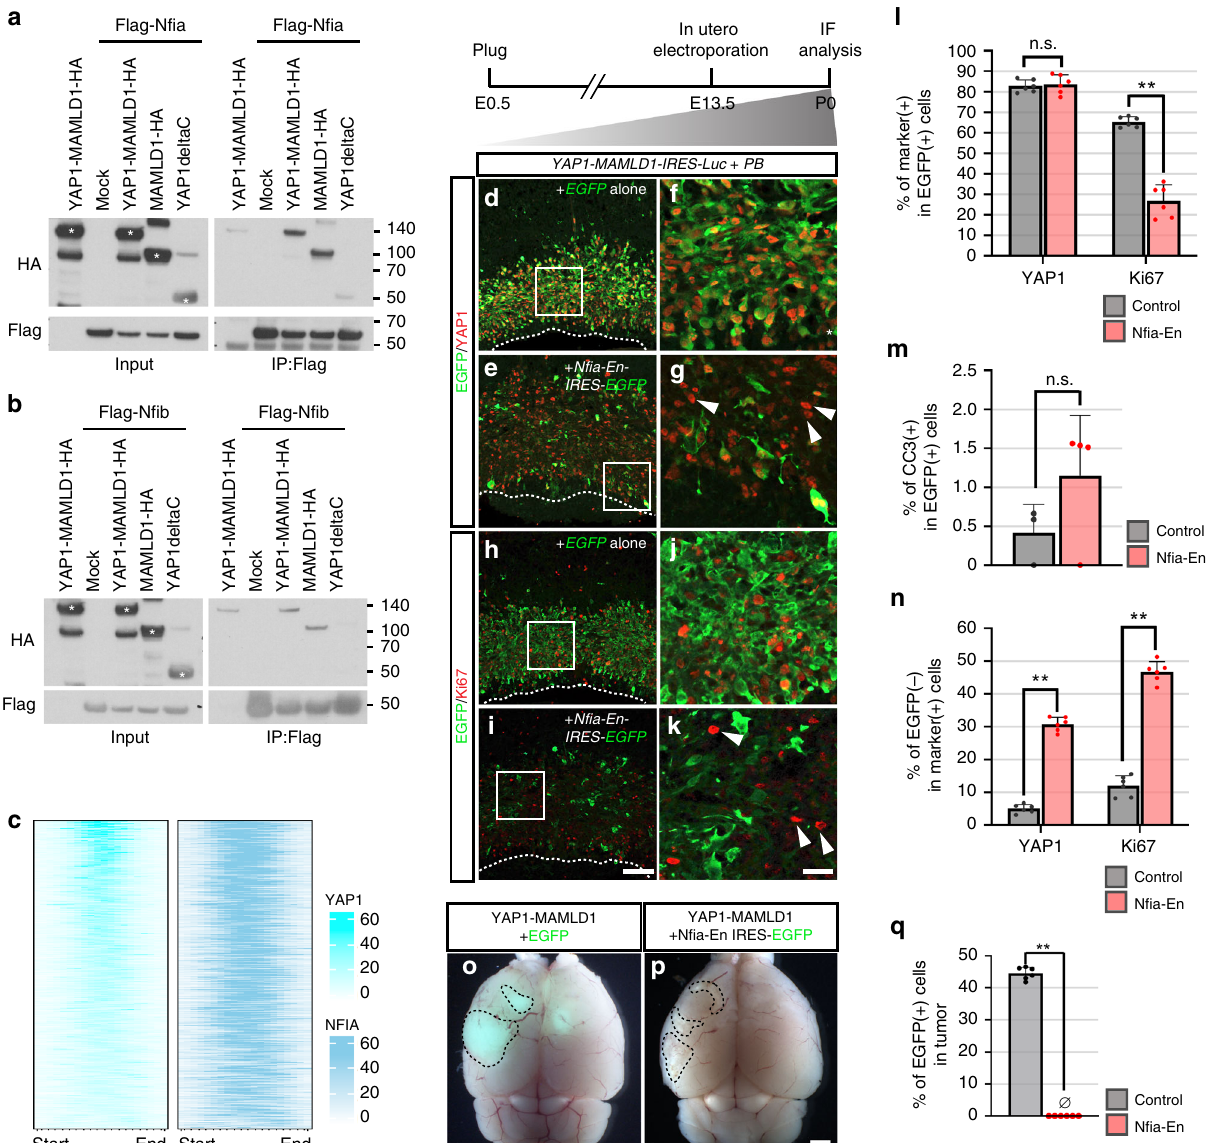
Fig. 7 Roles of Nuclear factor I proteins in YAP1-MAMLD1-driven tumorigenesis. a , b Immunoprecipitation assay of Flag-tagged a N fi a and b N fi b and HA- tagged YAP1 fusion-related proteins in HEK293T cells. Asterisks indicate overexpressed proteins according to their predicted molecular weights. c An enriched heatmap of YAP1 and NFIA ChIP-seq signals within the regions of ST-EPN-YAP1 group-speci fi c YAP1 peaks. d – g IHC of P0 brains with anti-GFP (green) and anti-YAP1 (red) antibodies after electroporation of YAP1-MAMLD1-IRES-Luc and either d , f EGFP alone or e , g N fi a-En-IRES-EGFP . Arrowheads in g indicate the cells expressing exogenous YAP1-MAMLD1 but N fi a-En-EGFP. f and g are high magni fi cation views of the area outlined by a rectangle in d and e , respectively. PB Piggybac transposase. h – k IHC of P0 brains with anti-GFP (green) and anti-Ki67 (red) antibodies after electroporation of YAP1- MAMLD1-IRES-Luc and either h , j EGFP alone or I , k N fi a-En-IRES-EGFP . Arrowheads in k indicate abnormally proliferating cells lacking N fi a-En expression. j and k are high magni fi cation views of the area outlined by a rectangle in h and i , respectively. Scale bar in i is 100 μ m (for d , e , h , and i ) and the scale bar in k is 25 μ m (for f , g , j , and k ). l The graph represents the percentages of YAP1- and Ki67-positive cells within EGFP-positive cells. Data obtained from three independent brain samples. ** p < 0.0001, n.s., not signi fi cant. The error bars indicate mean ± S.D. ( n = 6). m The graph indicates the percentage of YAP1- and cleaved caspase 3-positive cells within EGFP-positive cells. p = 0.554. The error bars indicate mean ± S.D. ( n = 4). n The graph indicates the percentage of YAP1- and Ki67-positive cells lacking EGFP expression. ** p < 0.0001. The error bars indicate mean ± S.D. ( n = 6). o , p Dorsal views of the brains bearing tumors from the mice electroporated with YAP1-MAMLD1-Luc with EGFP ( o ) and N fi a-Rn-IRES-EGFP ( p ). EGFP signals are detected only in ( o ). Scale bar, 1 mm. q The graph shows the percentage of EGFP-positive cells in the tumor tissues. ** p < 0.0001. The error bars indicate mean ± S.D. ( n = 6). Signi fi cant differences for l – n , q were assessed by t- Six days after in utero electroporation of YAP1-MAMLD1-IRES- respectively (the mean ± S.D., Fig. 7d – g, l and Supplementary Luc with either EGFP alone or with N fi a-En-IRES-EGFP Fig. 7i – l). At this stage, signi fi cantly fewer N fi a-En-expressing (corresponding to P0), 82.9 ± 3.0% and 83.8 ± 4.5% of EGFP- cells were proliferative (Ki67-positive) than control cells (65.4 ± positive cells expressed exogenous YAP1 in hyperplastic lesions 2.6% for control vs. 26.5 ± 7.8% for N fi a-En, the mean ± S.D., of EGFP -only and N fi a-En-IRES-EGFP -expressing brains, Fig. 7h – k, l). Meanwhile, we did not observe signi fi cant